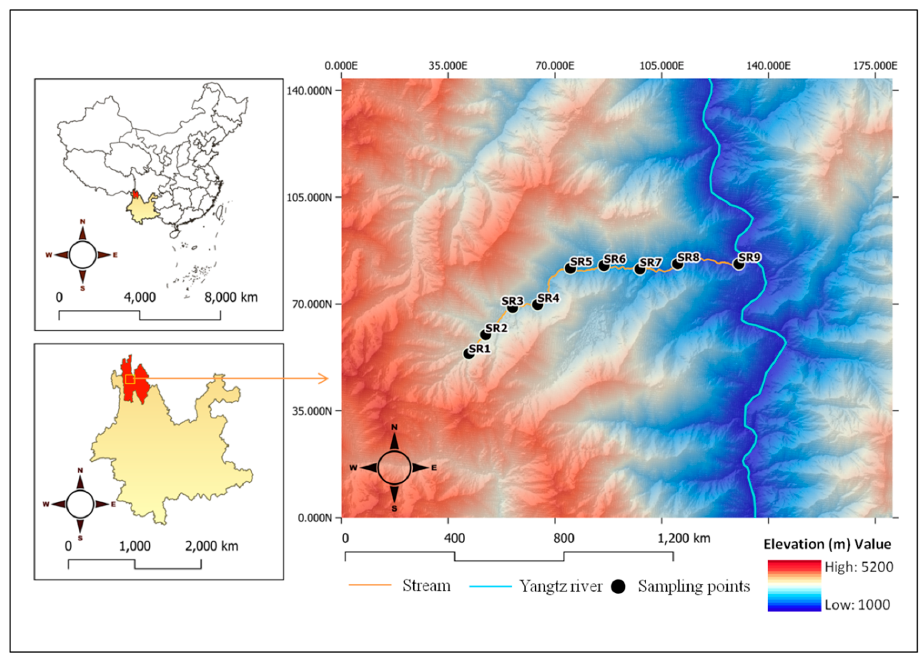
Figure 1. Map of the study region and sampling sites of an alpine stream namely Sharong (SR) situated in Baima Snow Mountain, Northwest Yunnan.